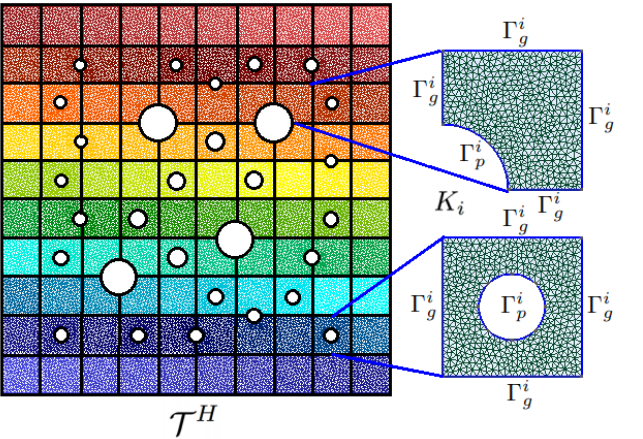
Figure 2. Coarse grid T H with coarse cell K i , Γ i g ∪ Γ i p = ∂ K i